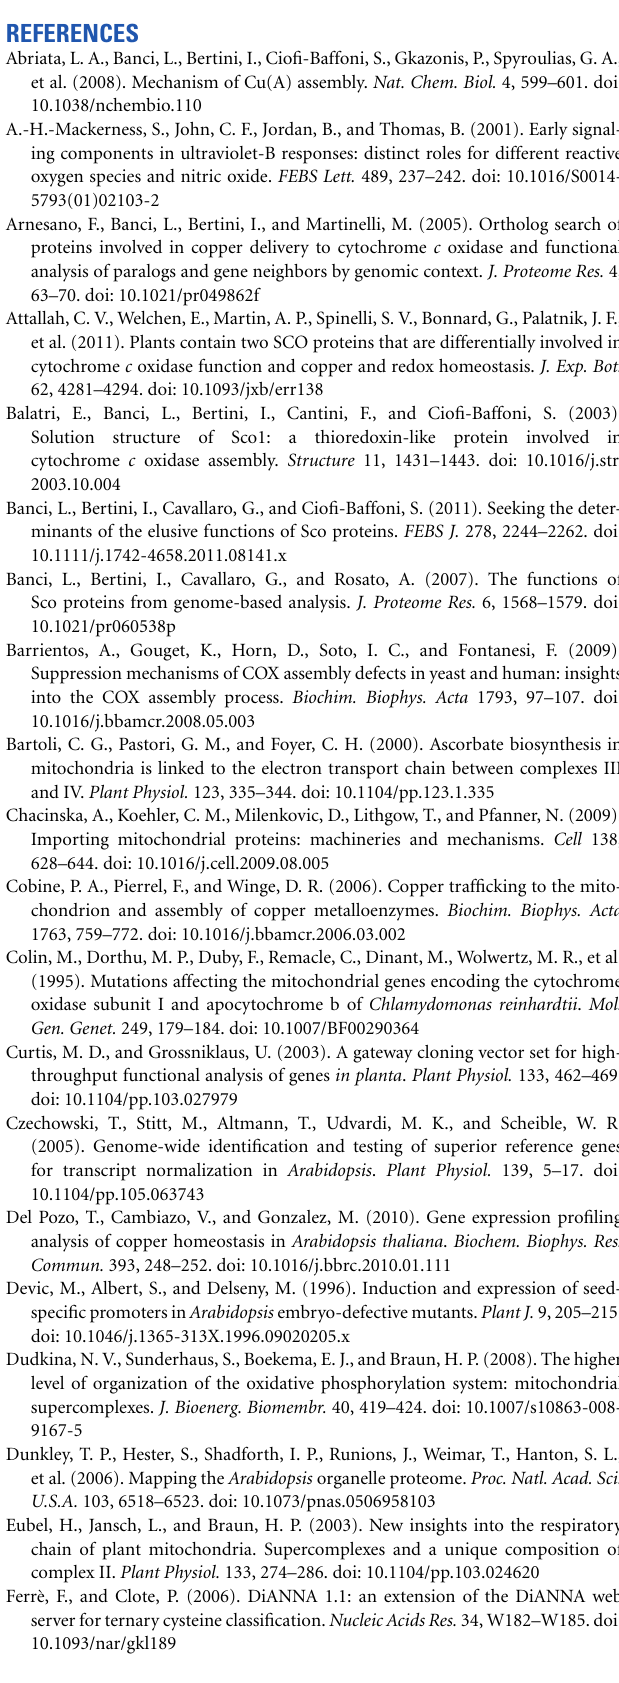
Supplementary Figure 2 | HCC2:GUS studies of different developmental stages. Various tissues from HCC2:GUS transgenic lines were stained for GUS activity: Ovules (A,B) , embryo (C) , cotyledon (D,E) , roots (F,G) , leaves (H,I) , flower buds (J) , flower (K) and silique (L) . The tissues stemmed from 7-day-old seedlings (D–G) and 4-week-old plants (A–C, H–L) , respectively. Exemplary guard cells are indicated by arrows in (E) . Staining of guard and trichome support cells was only observed in younger leaves. ch, chalaza; f, funiculus; r, root; h, hypocotyl; tsc, trichome